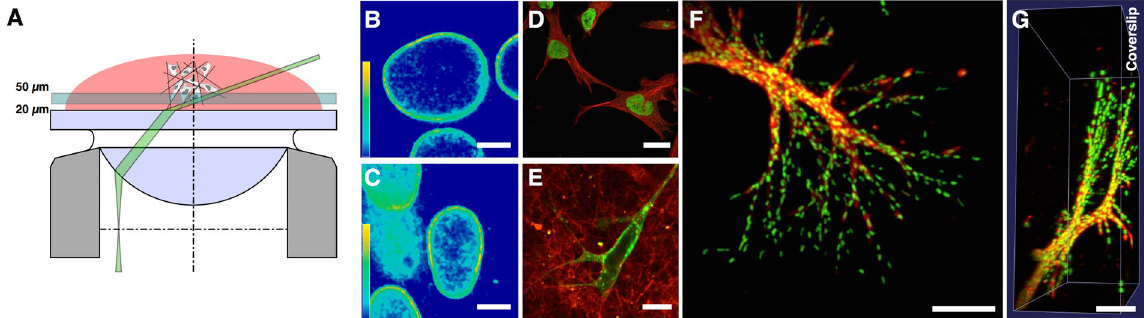
Figure 1. 3D cell culture conditions have a strong impact on intranuclear lamin distribution and overall morphology of MEF cells. ( A ) 3D cell culture system for single molecule microscopy and irradiation experiments: Cells embedded in the collagen-hydrogel are placed on a coverslip. A thin, highly inclined laminar optical sheet (HILO) is used to illuminate a subfraction of fluorescently labeled primary integrin antibodies of cells cultured in 3D in a distance of of 20–50 µ m to the coverslip. By combining STORM and HILO a sufficient imaging contrast is obtained to detect single molecule signals in 3D cultured cells. ( B ) Heat map of a Lamin A/C immunostaining of 2D versus ( C ) 3D cultured cells. Scale bar is 5 µ m, respectively. ( D ) A β -Tubulin (red) and H2A (green) immunostaining visualize the cytoskeleton and the nucleus of 2D cultured MEF cells. Scale bar is 25 µ m. ( E ) CMO (green) staining of the PM of a 3D cultured MEF cell cultured in a collagen hydrogel (red). Scale bar is 10 µ m. ( F ) MEF cells after a week-long 3D culture (maximum projection of a 3D confocal stack). ( G ) 3D volume rendering of ( F